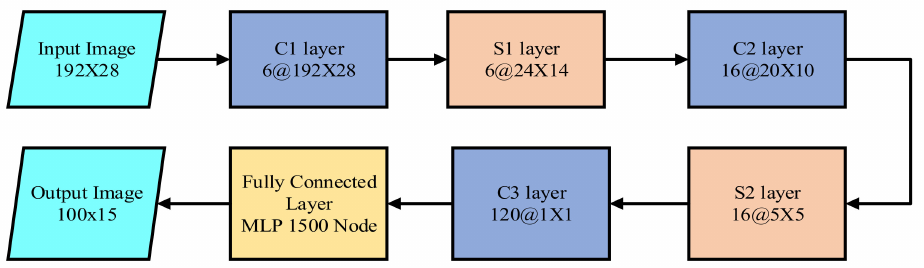
Figure 2. The architecture of CNN based lane marking detection technique.